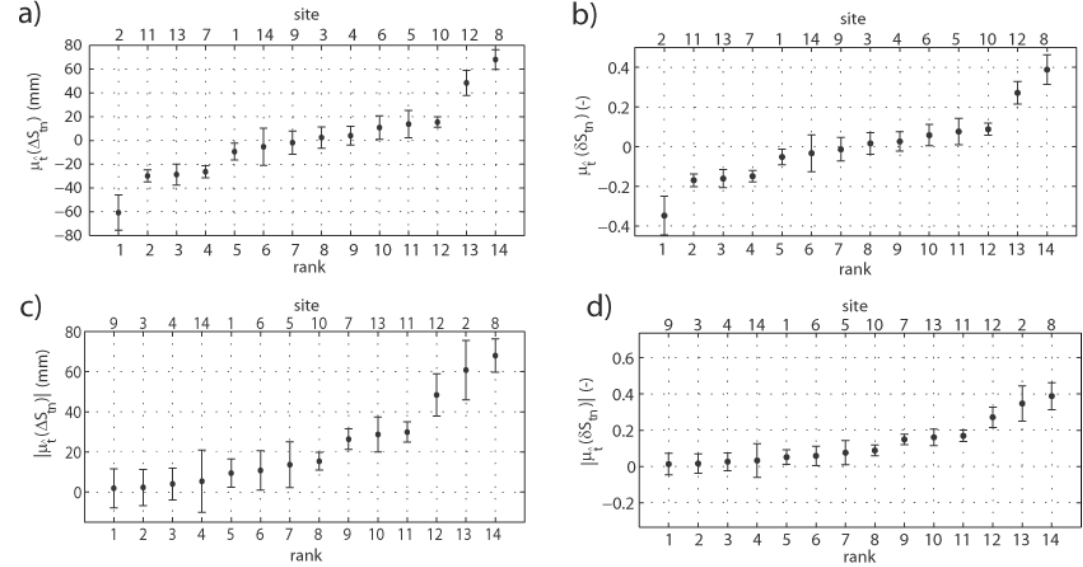
(δS( tn )) , (b) the temporal mean of b t (1S( tn )) | . The vertical lines represent b t